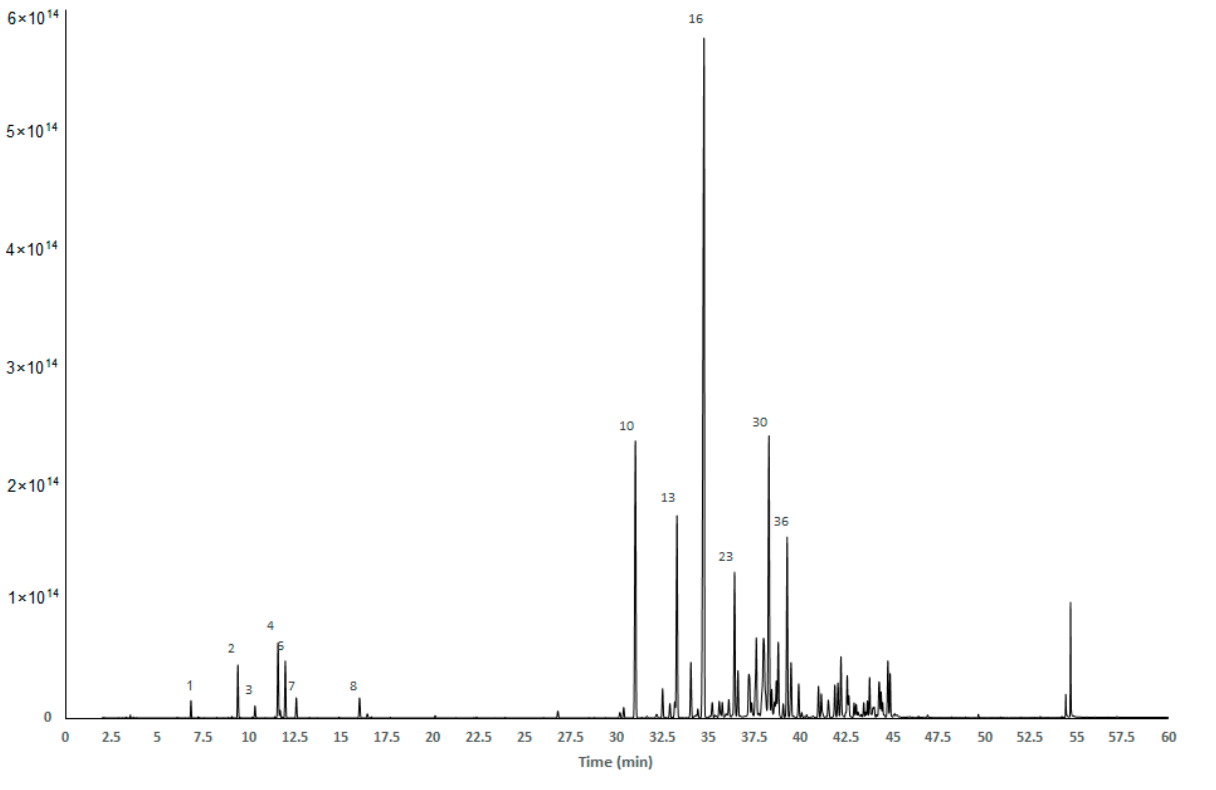
Figure 1. GC-MS chromatogram of Myrcianthes discolor EO, through a 5%-phenyl-methylpolysiloxane capillary column. Table 1. Chemical compounds present in the essential oil of the leaves of Myrcianthes discolor .